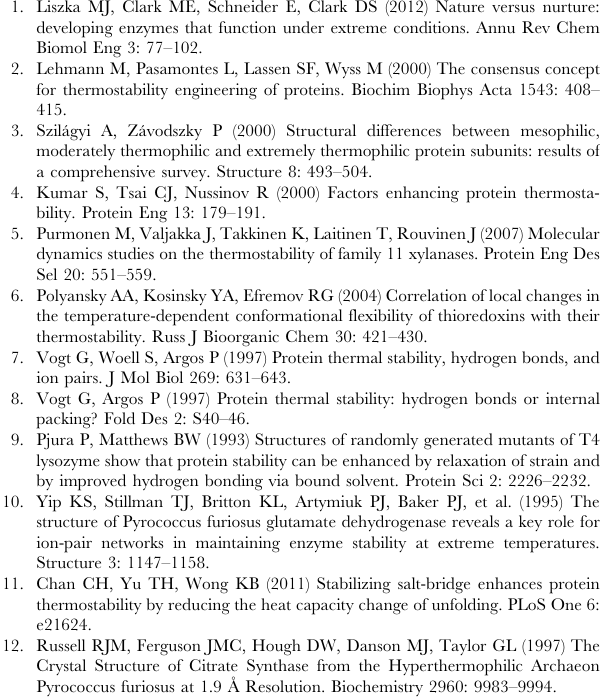
Table S4 Residues with highest clustering coefficient. Table S5 Ten residues in each mutant showing maxi- mum difference in the clustering coefficient. Table S6 Contacts made in all the mutants. Table S7 Contacts lost in all the mutants. Table S8 Community membership of the nodes in all the PCNs. Table S9 List of all the salt bridges in WT and mutant Table S10 SASA values for crystal structures. Text S1 Supplementary Methods and